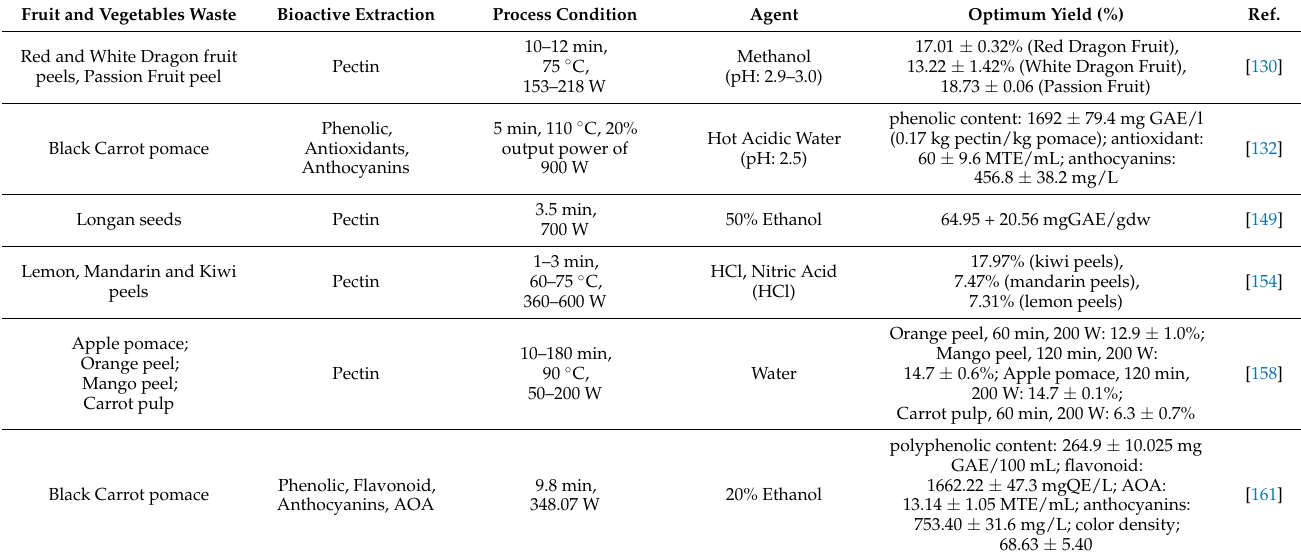
Table 6. Progress studies of FVW in the application of microwave-assisted